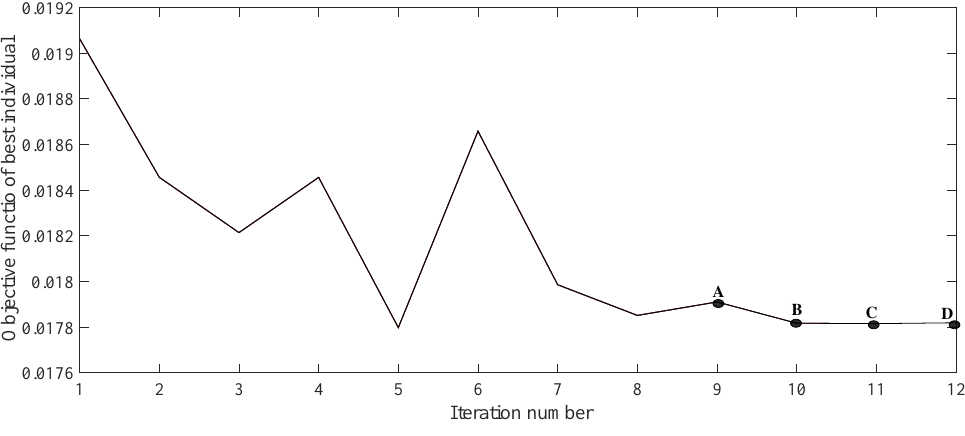
Figure 7. Selection of the stopping criterion for the PBIL algorithm.